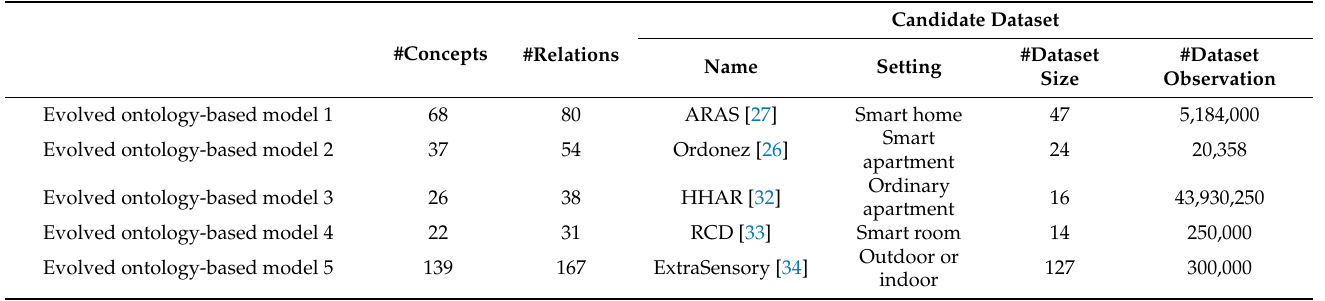
Table 7. Insights in the evolved ontology-based